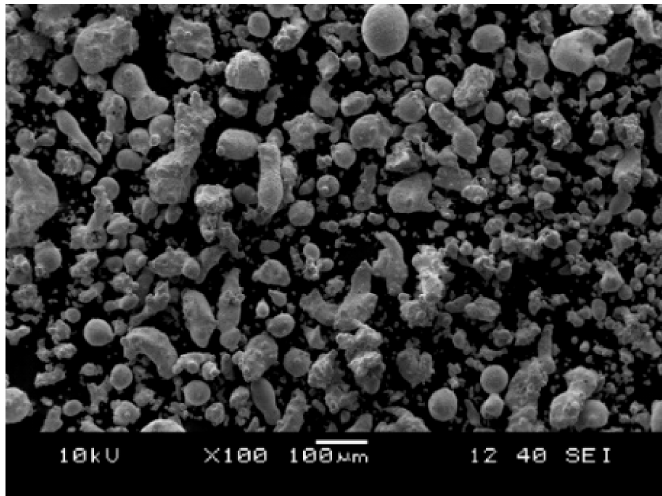
Figure 3. SEM image of bronze